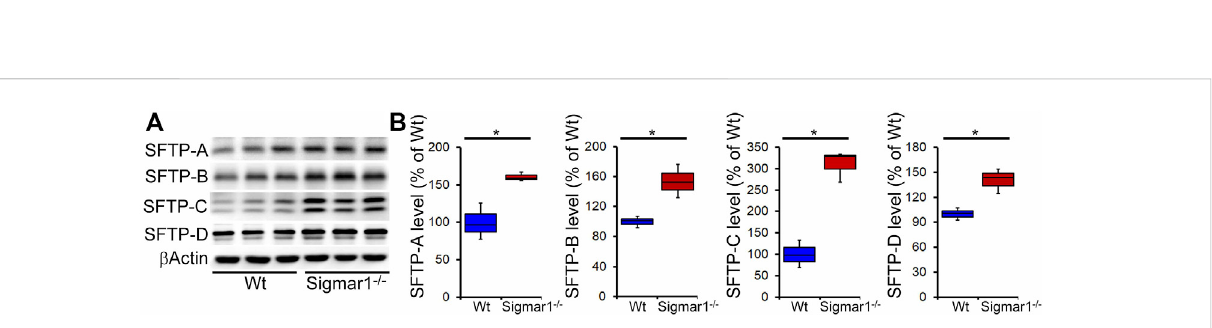
FIGURE 7 Increased surfactant protein levels in aged Sigmar1 − / − mouse lung. (A) Western blot images and (B) densitometric quanti fi cations showed elevated levels of all four surfactant proteins (SFTP-A, SFTP-B, SFTP-C, SFTP-D) in the aged Sigmar1 − / − mouse lungs compared to age match littermate Wt mouse lungs (n = 3 per group). The Kruskal – Wallis test determined p values, and p < 0.05 was considered statistically signi fi